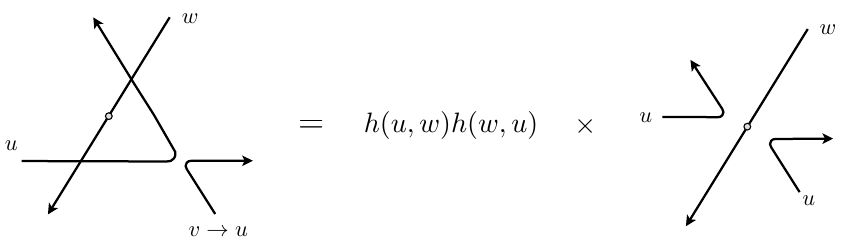
Figure 5 . Illustration of the decoupling of the matrix part for the three-magnon con(cid:12)guration. In the limit where v u the uv interaction reduces to a permutation, ! lines can be disentangled up to an overall abelian factor. The relation shown here is equivalent to the unitarity of after crossing the magnon w . The abelian factor spit out by the matrix part S completes the decoupling of the dynamical factor in (2.23) in the limit v